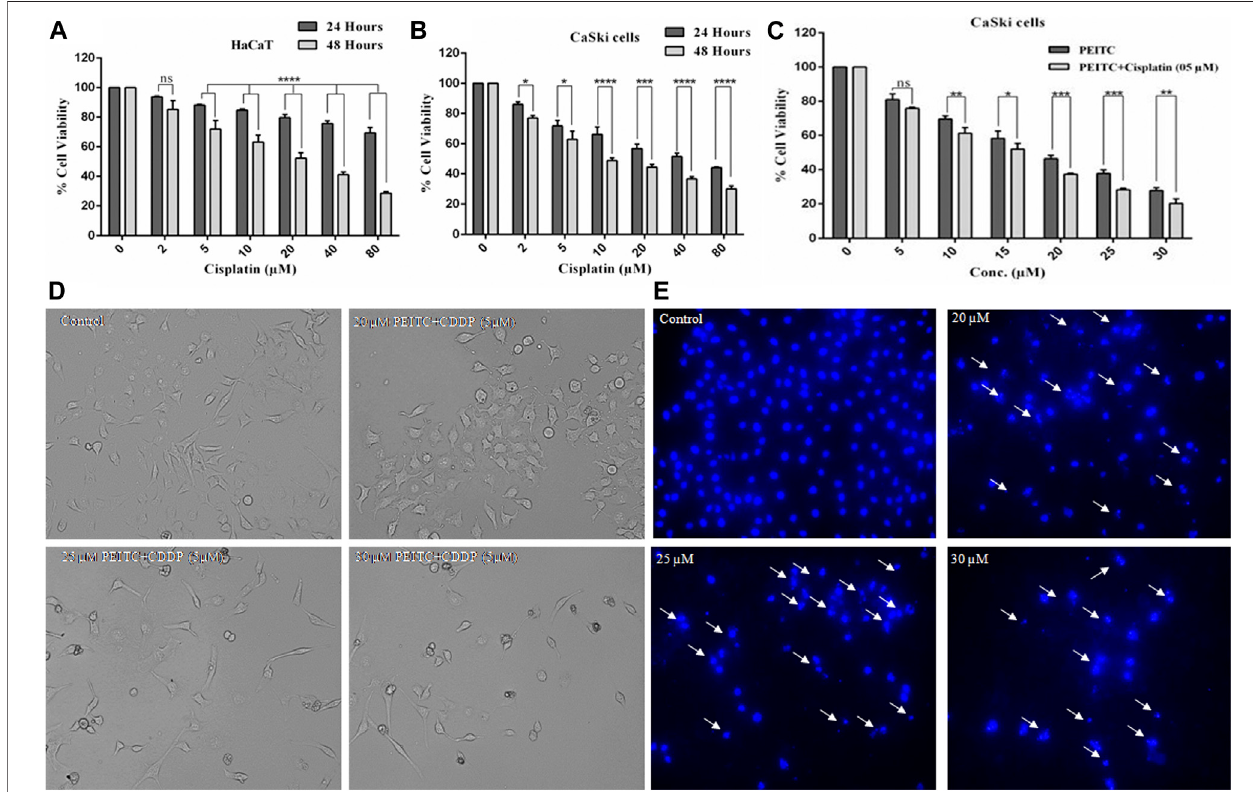
FIGURE 2 | (A) Cisplatin exerted cytotoxicity on the normal cell line (HaCaT). (B) Cisplatin-treated CaSki cells showed signi fi cant reduction in cell viability in a dose and time dependent manner. (C) Percent cell viability of CaSki cells exposed to various doses of PEITC (5-30 μ M) accompanied with 5 μ M cisplatin compared to individual PEITC-treatment (5-30 μ M). (D) Combined doses of PEITC with sub-optimal concentration of cisplatin (5 μ M) exerted signi fi cant cytotoxic effects on CaSki cells. (E) CaSkicellswereincubatedwithdifferentconcentration ofPEITC(20,25and30 μ M)for48h,thennuclearcondensationandfragmentation (whitearrows) was detected by fl uorescence microscopy. The data represents mean ± SD of three independent experiments. The image is the representation of three independent experiments. * p value < 0.05 compared with the untreated control was considered statistically signi fi cant.